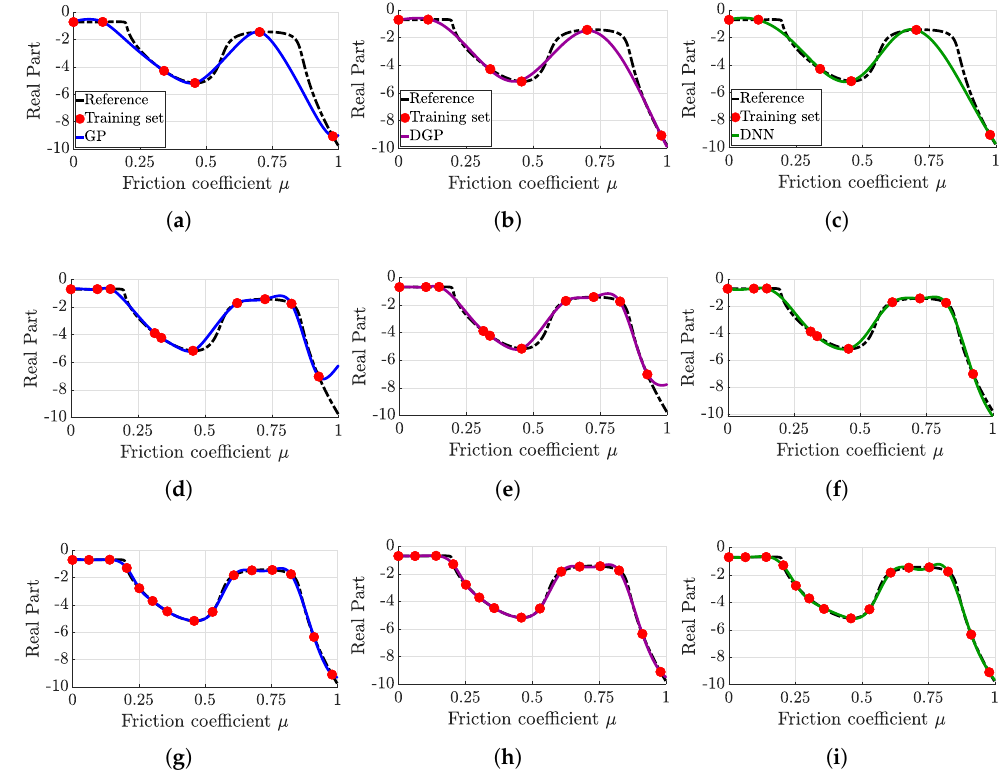
Figure 7. Comparison of each surrogate model approximation with respect to the sampling density. ( a ) Gaussian process ( 6 points ), ( b ) deep Gaussian process ( 6 points ), ( c ) deep neural network ( 6 points ), ( d ) Gaussian process ( 10 points ), ( e ) deep Gaussian process ( 10 points ), ( f ) deep neural network ( 10 points ), ( g ) Gaussian process ( 15 points ), ( h ) deep Gaussian process ( 15 points ), ( i ) deep neural network ( 15 points ). Table 11. CRMSE values with respect to the sampling density for each surrogate